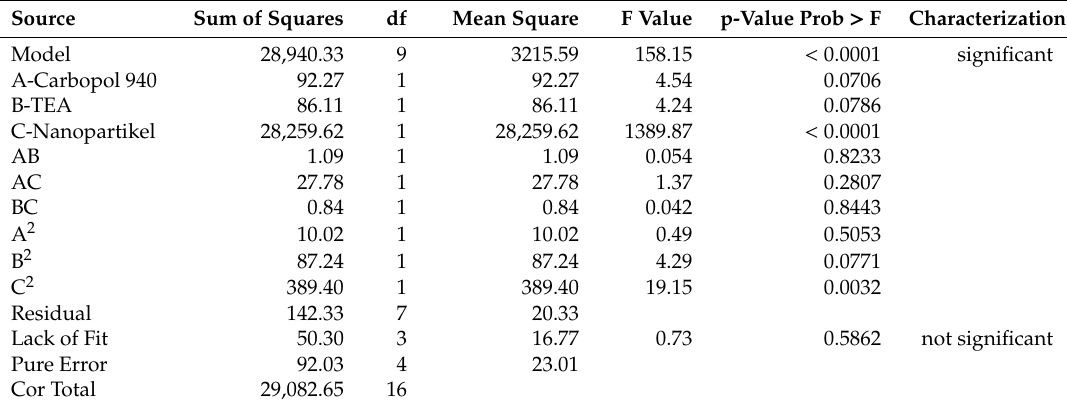
Table 7. ANOVA analysis for the quadratic model of the total phenolic content of the arabica co ff ee ground nanoparticles gel